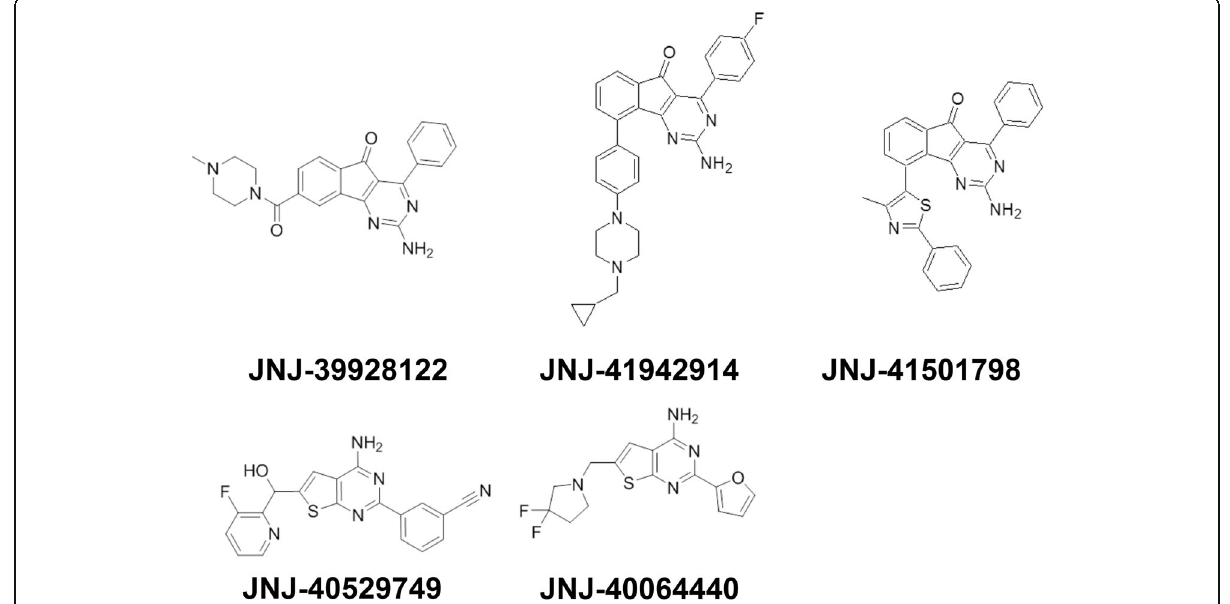
Fig. 1 Molecular structures of the JNJ antagonists from Janssen Research &